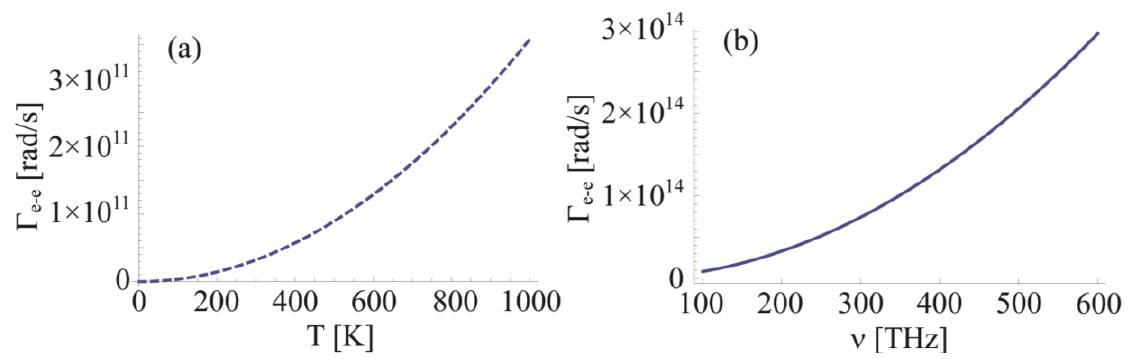
Figure 8. ( a ) Temperature dependence of the electron-electron scattering in DC regime ( ω = 0); ( b ) frequency dependence of the electron-electron scattering at room temperature ( T = 293 K). Au is